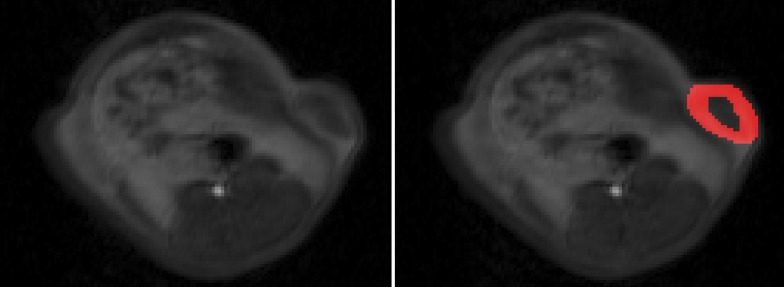
Representative axial TWIST MR images of a rat with a subcutaneous colon carcinoma xenograft over the left lateral flank after 7 days of regorafenib therapy.Note the hypointense tumor center corresponding to areas of beginning or present tumor necrosis and consecutively altered contrast media kinetics. For the assessment of tumor microcirculation a donut-shaped region-of-interest (red area) was drawn over vital tumor areas of the tumor periphery using semiquantitative AUC maps.